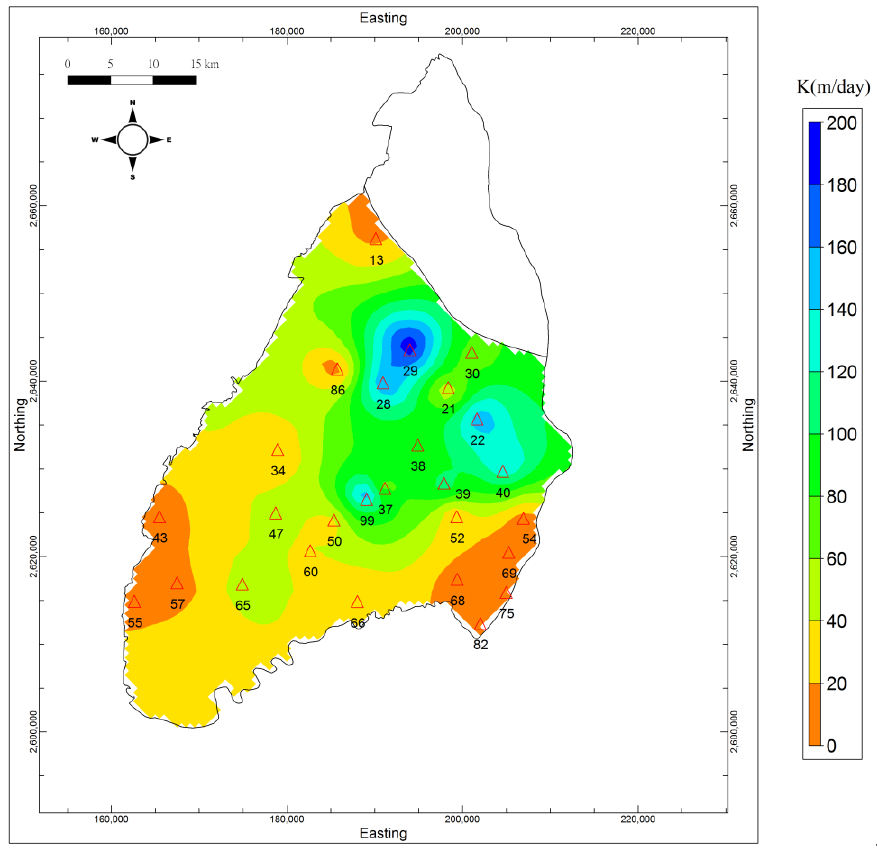
Figure 11. K fields of zone 1, zone 2, and zone 5 derived from the ordinary kriging method.